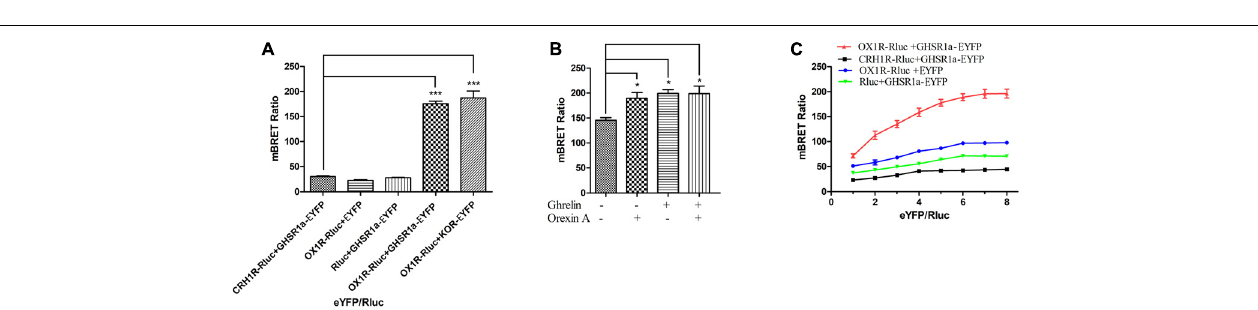
FIGURE 1 | Co-expression and co-localization of GHSR1a and OX1R in HEK293 cells. Analysis of GHSR1a- and OX1R-transfected HEK293 cells using laser confocal microscopy. OX1R-ECFP (cyan) and GHSR1a-EYFP (yellow) were expressed in HEK293 cells. OX1R and GHSR1a confocal images are merged to show co-localization regions (green).